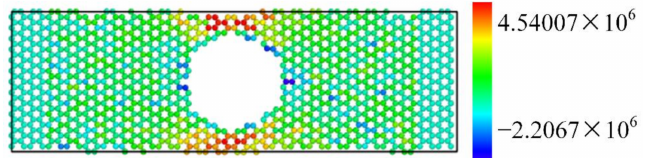
Figure 11. Graphene stress cloud chart during